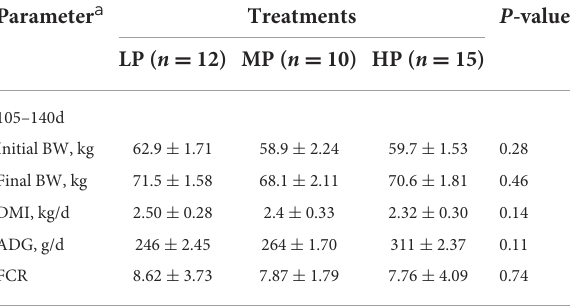
TABLE 2 Effects of three different dietary protein levels on growth performance in Hu ewes during late pregnancy. Parameter a